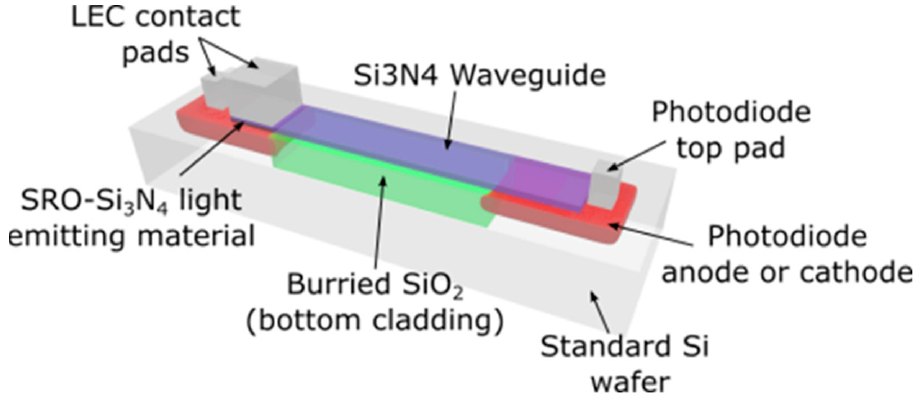
Figure 7. Schematic of a monolithic transceiver with light emitting diode based on SRO (LEC), waveguide, and photodiode.